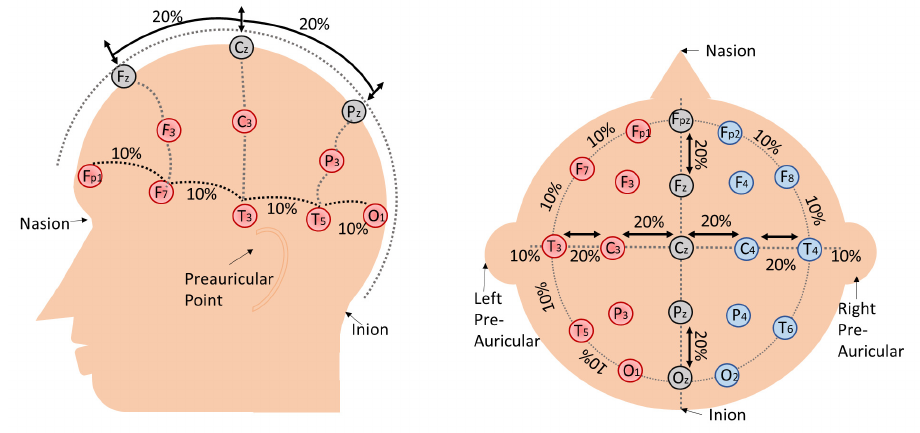
Figure 3. The international 10–20 standard electrode position system.The left image presents a left side view of the head with electrode positions, and the right image shows a top view of the